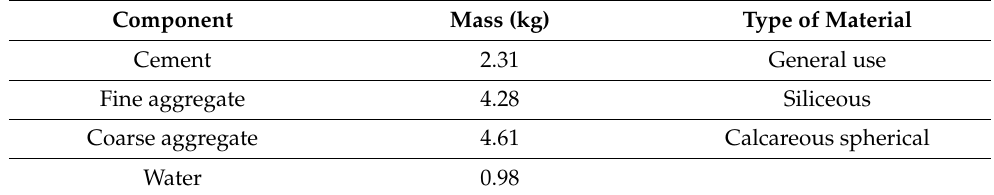
Table 2. Proportioning mixture of the concrete.